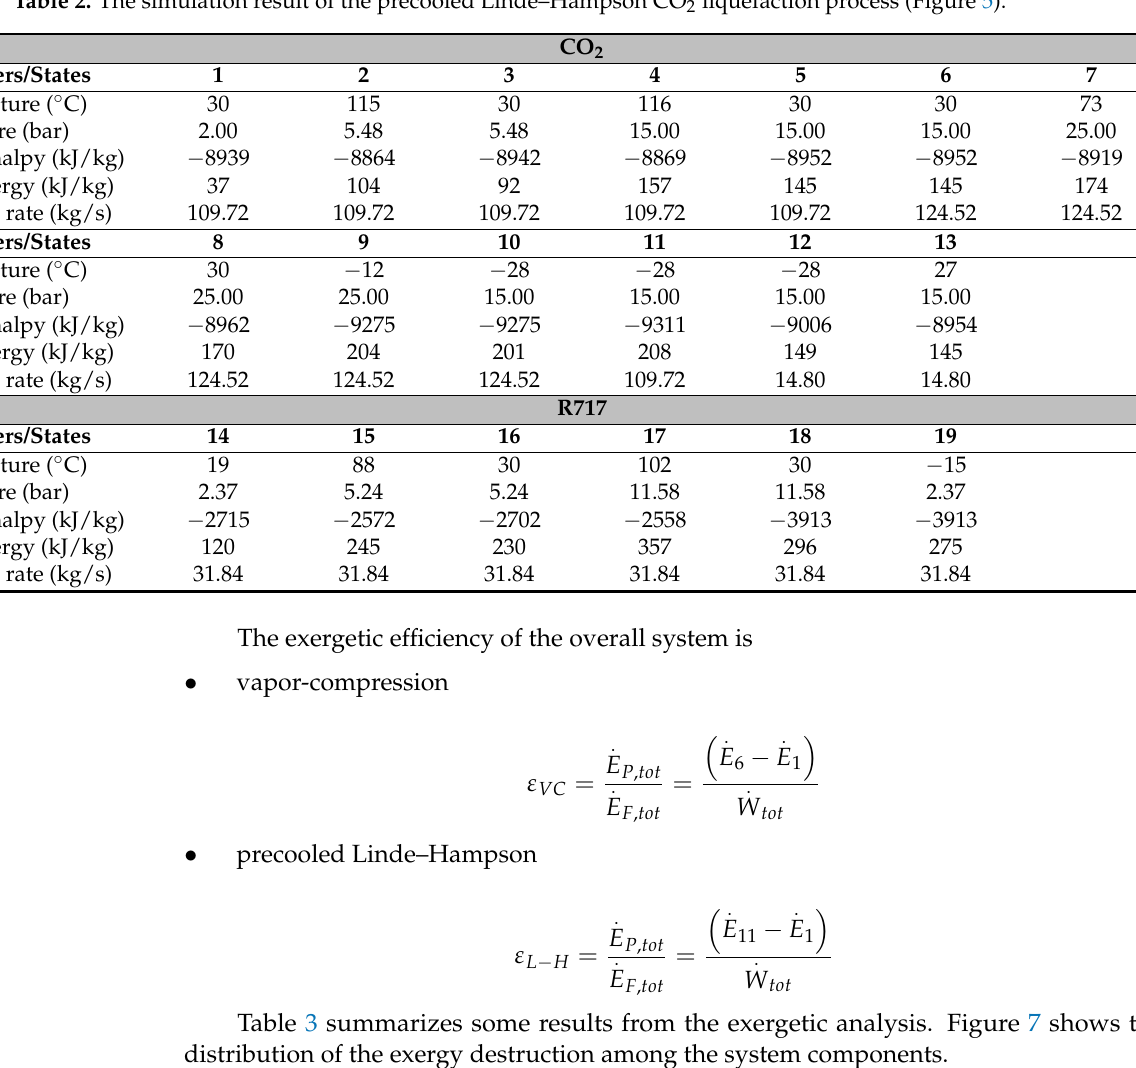
Table 2. The simulation result of the precooled Linde–Hampson CO 2 liquefaction process (Figure 5).